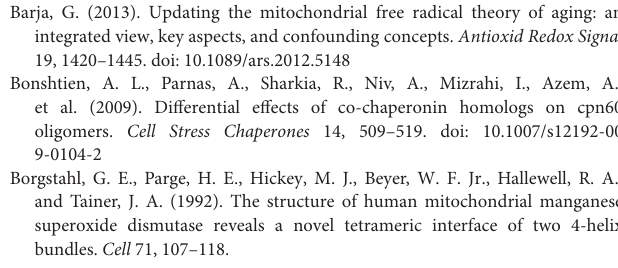
Supplementary Figure S1 | Mass spectrometric analysis of HSP10 full-length and core bands. (A) Full-length and core bands from a limited proteolysis experiment like the one shown in Figure 2D were excised and prepared for mass spectrometry (LC-MS/MS). Elution profiles for detected peptides are shown in (A) . The arrows point to peptides that are highlighted in the corresponding colors in (B) . Green arrow: amino acids 41–54 (VLQATVVAVGSGSK), magenta arrows: amino acids 71–80 (VL-x-PEYGGTK with Leu (wt) or Phe (mutant), respectively, at the “x”-position), blue arrow: amino acids 9–15 (FLPLFDR). (B) HSP10 subunit R in schematic representation. Position of lysine and arginine residues are highlighted in yellow, the mutated leucine-73 residue is shown as sticks in red and the amino (N) and carboxy-terminal (C) positions are depicted. The representation was made with Discovery Studio Visualizer v.4.5 (Biovia) using PDB coordinates for the human HSP60/HSP10 complex (4PJ1). Supplementary Figure S2 | RT-qPCR quantitation of transcript levels. RNA purified from patient and three individual control fibroblasts was reverse transcribed into cDNA and subjected to quantitative analysis with qPCR TaqMan assays. Error bars represent standard error of mean for biological triplicates. Filled bars: Patient, open bars: mean from three pooled controls. P -values were obtained with student’s t -test and showed no significant differences. Supplementary Figure S3 | Mitochondrial morphology. Fibroblasts from the patient and a healthy control individual were seeded at 50% confluence in 6-well plates 24 h before the analysis. The fibroblasts were stained with 100 nM Mitotracker Green for 30 min at 37 ◦ C. Pictures were obtained with the EVOS FLoid Cell Imaging Station as described in materials and methods. Two representative pictures each of the control (left panel) and the patient (right panel) fibroblasts are shown. Supplementary Figure S4 | Cellular viability, thiol redox status, mitochondrial membrane potential, and mitochondrial oxygen consumption profiling. (A) Cellular viability measured as the percentage of viable cells. (B) Cellular thiol redox status measured as intensity of the Vita-Bright 48 (V.B-48) fluorescent dye. V.B-48 becomes fluorescent when it reacts with reduced thiols which are used to quench molecules that are damaging to the cell, such as free radicals, and are used as a measurement for general cellular oxidative/reduced status. (C) The mitochondrial membrane potential measured as the red/green ratio of the fluorescent dye JC-1. An assay control (control cells treated with the uncoupler CCCP) is also shown. (D) Mitochondrial oxygen consumption rate profiling. Oxygen consumption rate (OCR) of patient and control fibroblasts in dependence of addition of modulators [1: oligomycin (inhibitor of complex V); 2: FCCP (uncoupler); 3: antimycin A and rotenone (inhibitors of complex I and III, respectively)] was measured using the Mito Stress test-kit and the Seahorse XF e 96 extracellular flux analyzer. Samples from 3 different control fibroblasts and 3 independently grown cultures of the patient fibroblasts were analyzed. OCR was normalized to total protein amount quantified by the Bradford assay. Supplementary Table S1 | Oligonucleotide primer sequences. Supplementary Table S2 | Genes investigated in exome